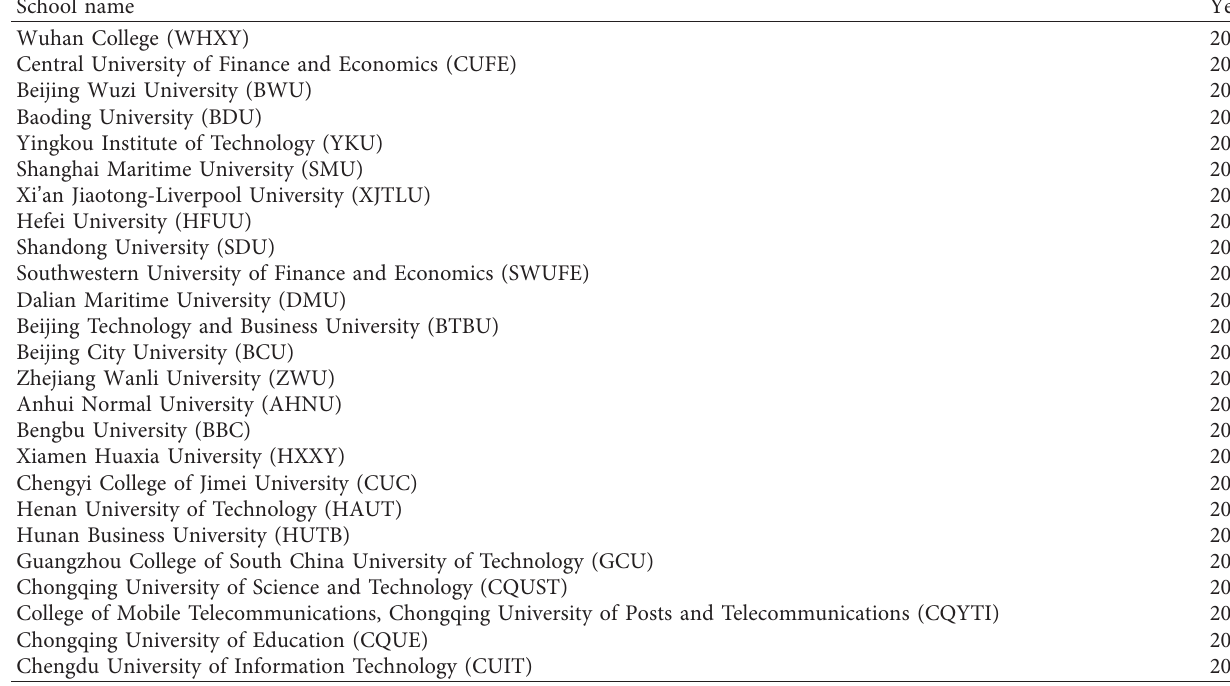
Table 2: List of universities that are specialized in